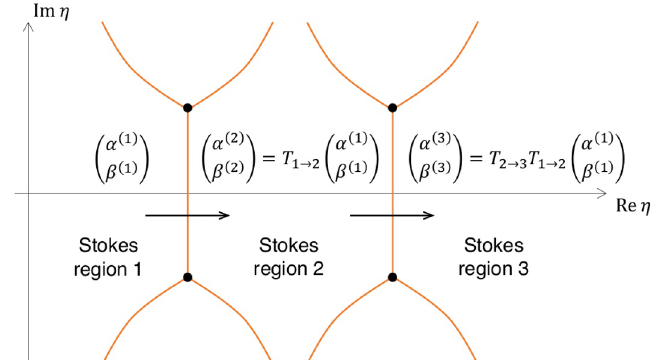
Figure 2 . An illustration of the Stokes phenomenon. In each Stokes region, a general solution is written as α ( i ) ψ ( i ) ( η, ~ ) + β ( i ) ψ ( i ) ( η, ~ ) where α ( i ) ( β ( i ) ) multiplies the positive (negative) frequency + − EWKB basis solution ψ ( i ) ( ψ ( i ) ). The coefficients in adjacent regions are related by a unitary + − transformation. Nonzero off-diagonal entries in the unitary matrix T i → j imply a mixing of positive and negative frequency modes, which is the Stokes phenomenon. To study cosmological GPP, we take α (0) = 1 and β (0) = 0 in the region containing η → −∞ , and the density of gravitationally produced particles is proportional to | β ( i ) | 2 in the region containing η → + ∞